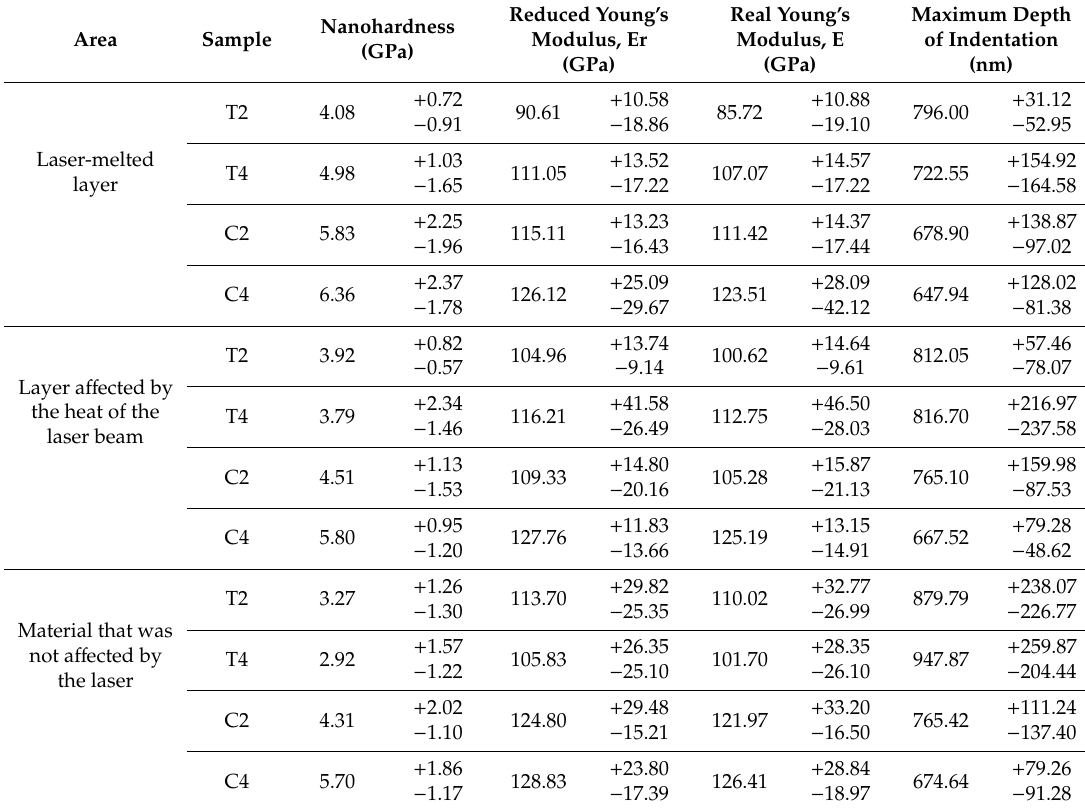
Table 4. Mechanical and nanoindentation properties of the tested